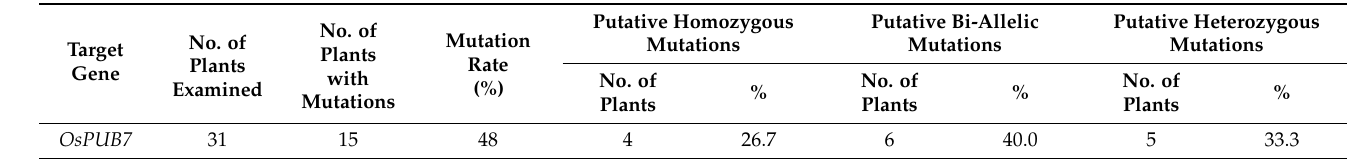
Figure 4. Identification of mutation genotypes in OsPUB7 generated using CRISPR/Cas9 technology using NGS analysis in Dongjin (WT) and T 0 plants. Green indicates the target sequence, and blue indicates the PAM region. The InDel sequence of the target locus is shown in red. Deletion in the analysis region is indicated by “-”, and insertion is indicated by an insertion of nucleotide such as “T” or “G”. The minus ( − ) and plus (+) signs indicate the number of nucleotides deleted and inserted at the target sites, respectively. WT, wild type sequence with no mutations. Table 1. Analysis of OsPUB7 transformation efficiency and mutation type ratio at the target site in T 0 mutant rice